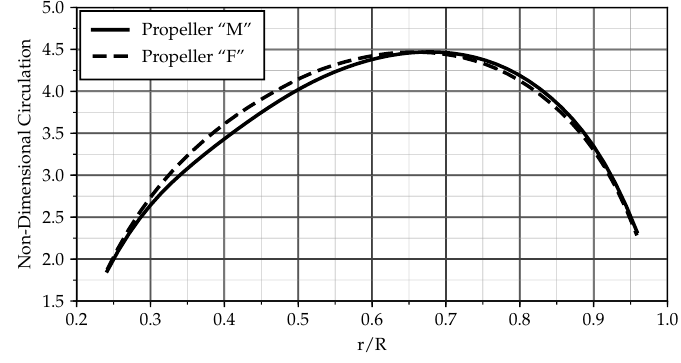
Figure 7. Circumferentially averaged axial velocities used for propeller design.